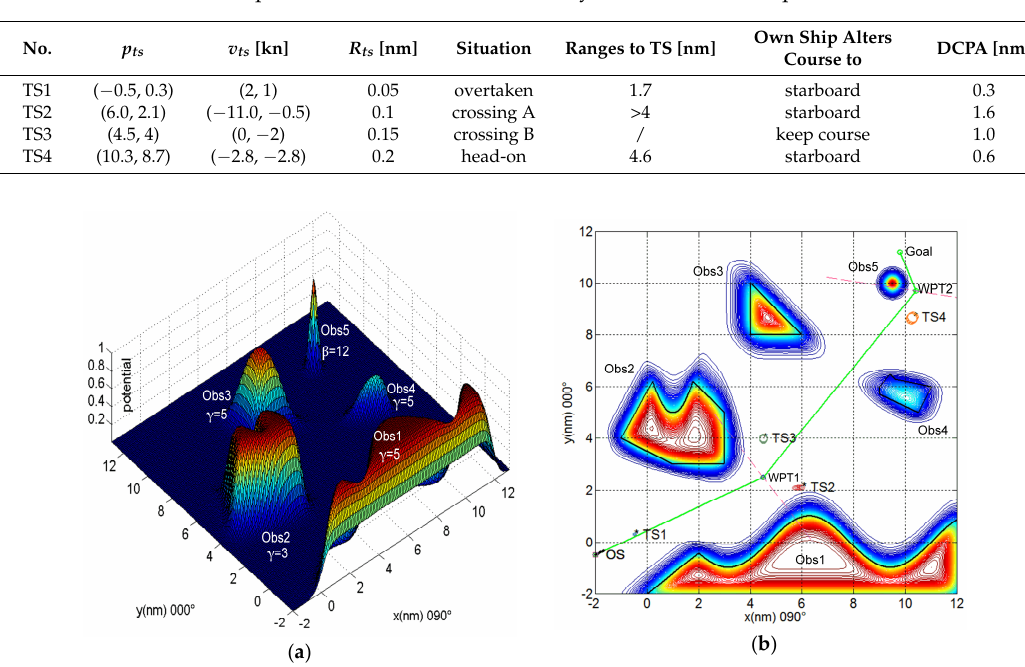
Table 9. Initial inputs and simulation results for dynamic TSs in a complex environment.